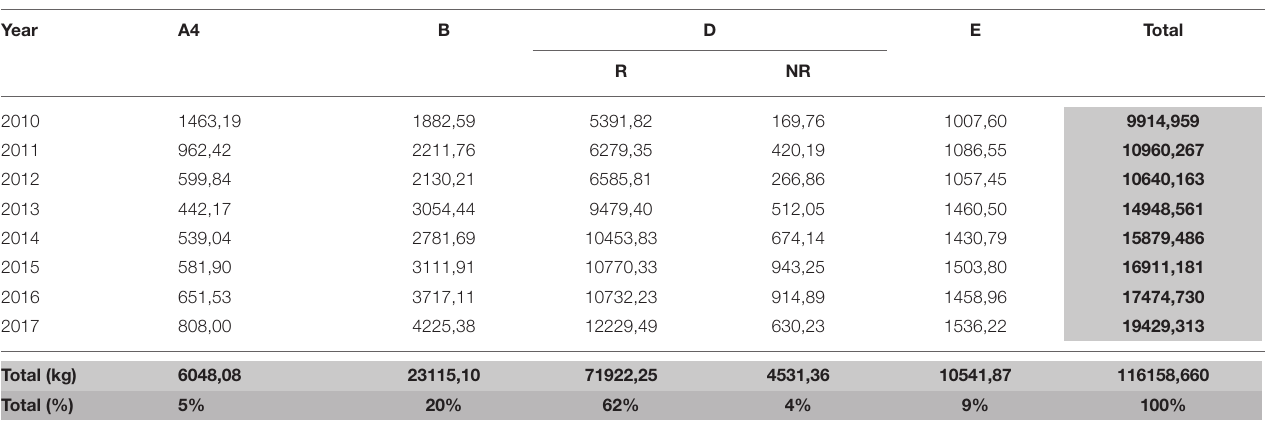
TABLE 1 | Amount of waste produced per year, divided into